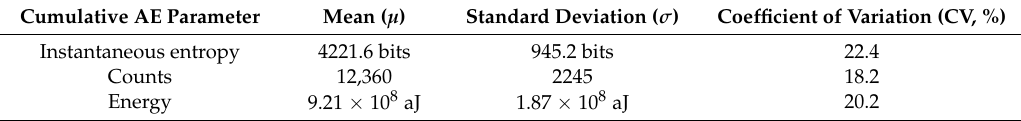
Table 3. Statistics for final cumulative values of instantaneous entropy, counts, and